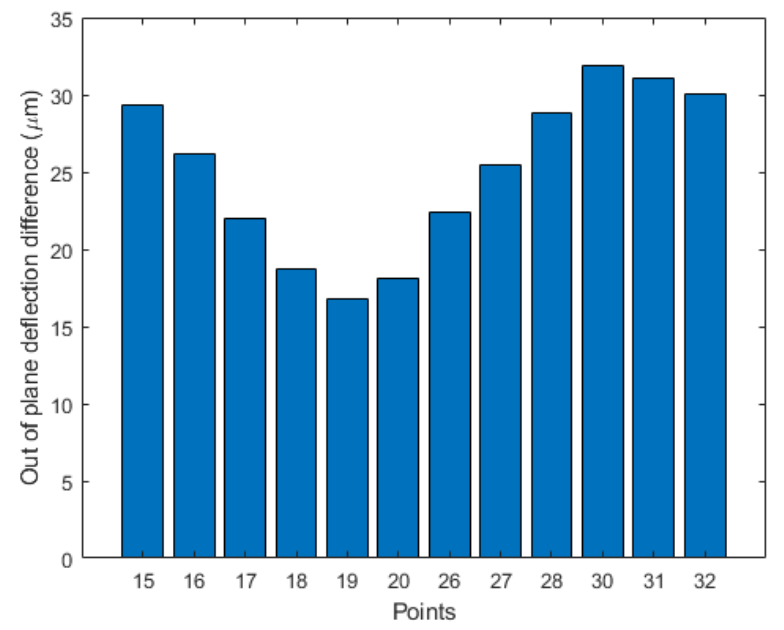
Figure 12. Difference in out-of-plane deflection between the reference and reduced wafers for selected